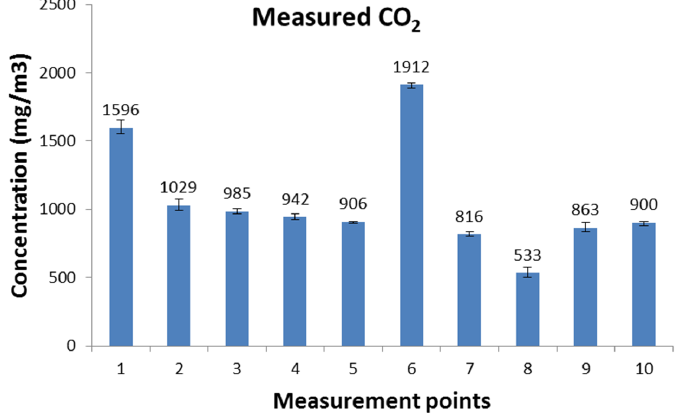
Figure 7. Concentration of measured CO 2 at ten measurement points.